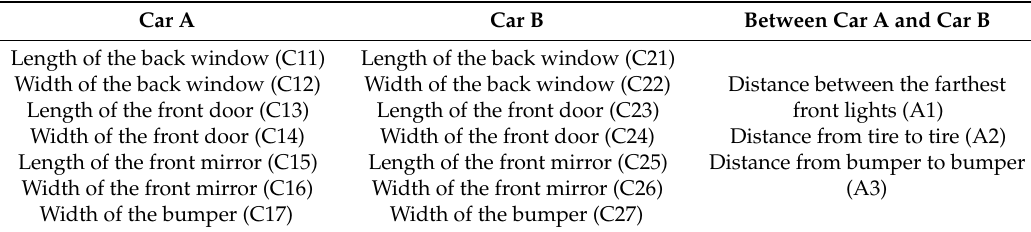
Figure 3. Scenario 1 Simulated accident scene. Table 2. Measured segments.